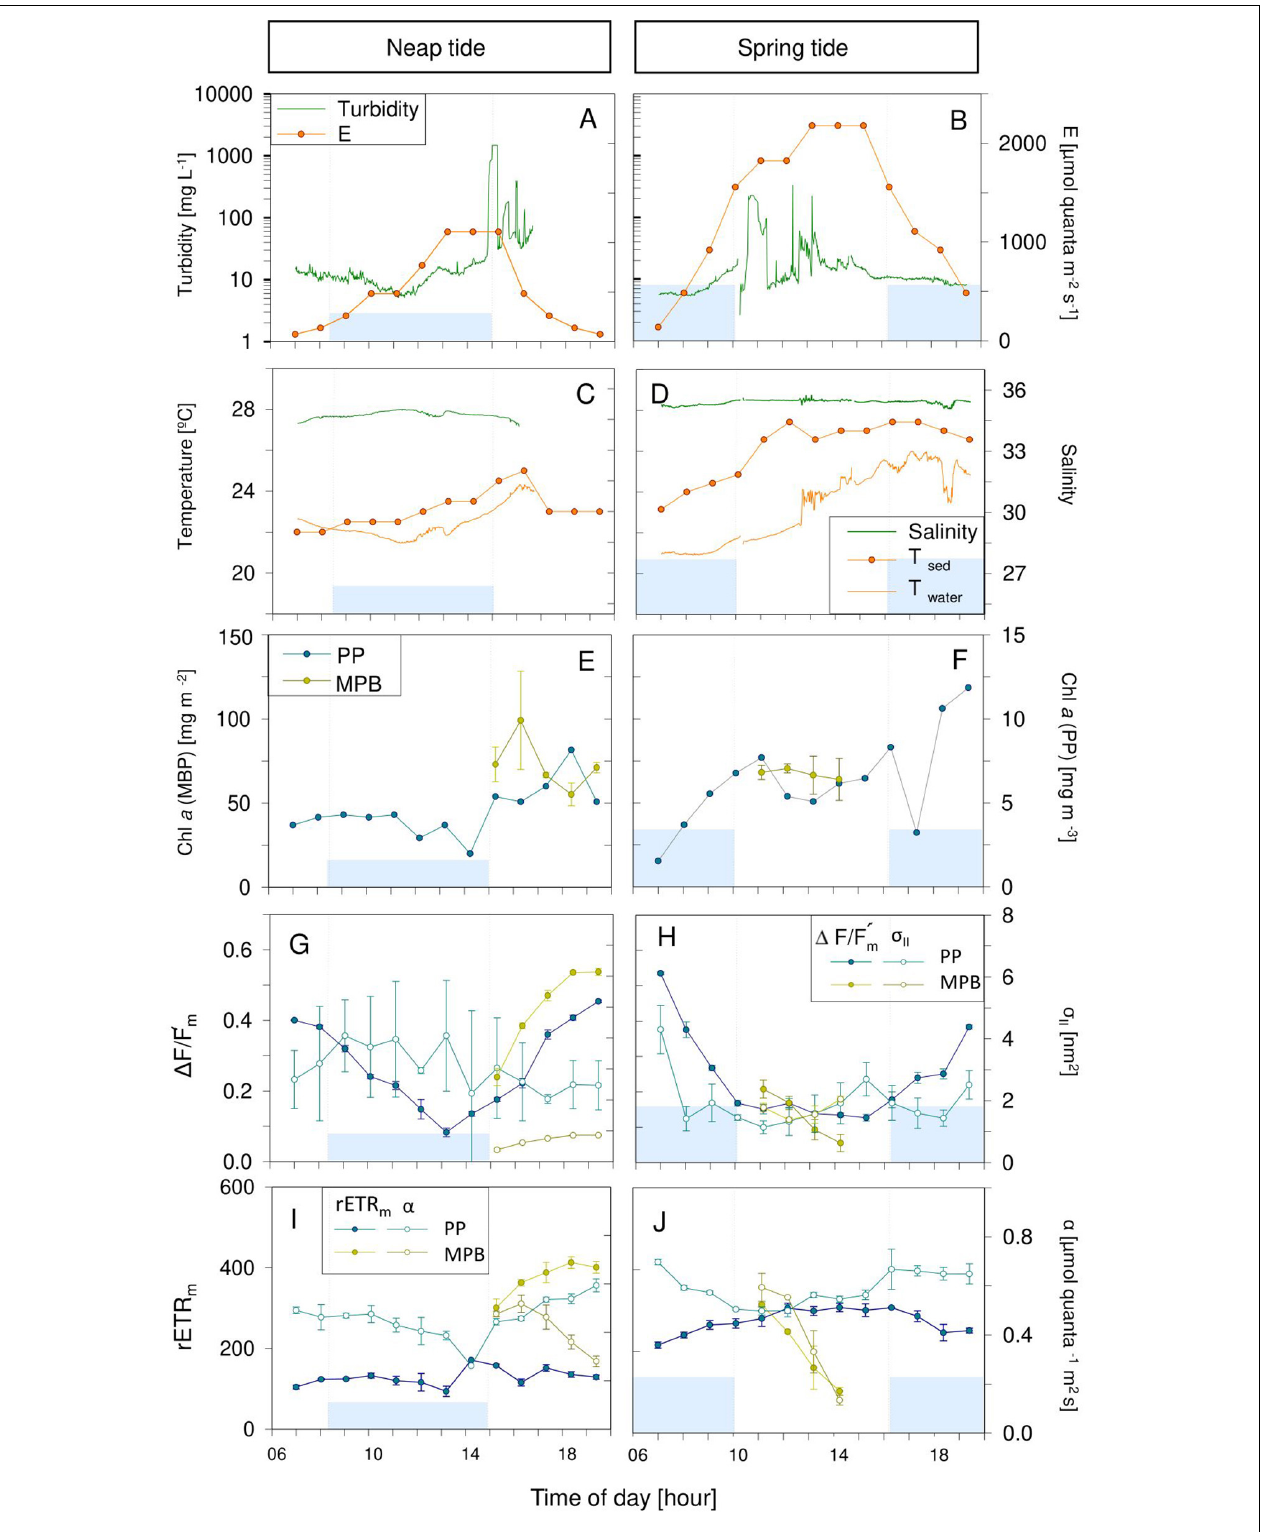
FIGURE 3 | Hourly variation of abiotic (A–D) and photophysiological (E–J) parameters along one day in Torreira (TO) during neap (A,C,E,G,I) and spring tide (B,D,F,H,J) in July 2013. Blue areas represent high tide; vertical bars demonstrate the beginning and end of the high tide. Mean values of three replicates. Error bars represent one standard error. PP, phytoplankton; MPB, microphytobenthos.